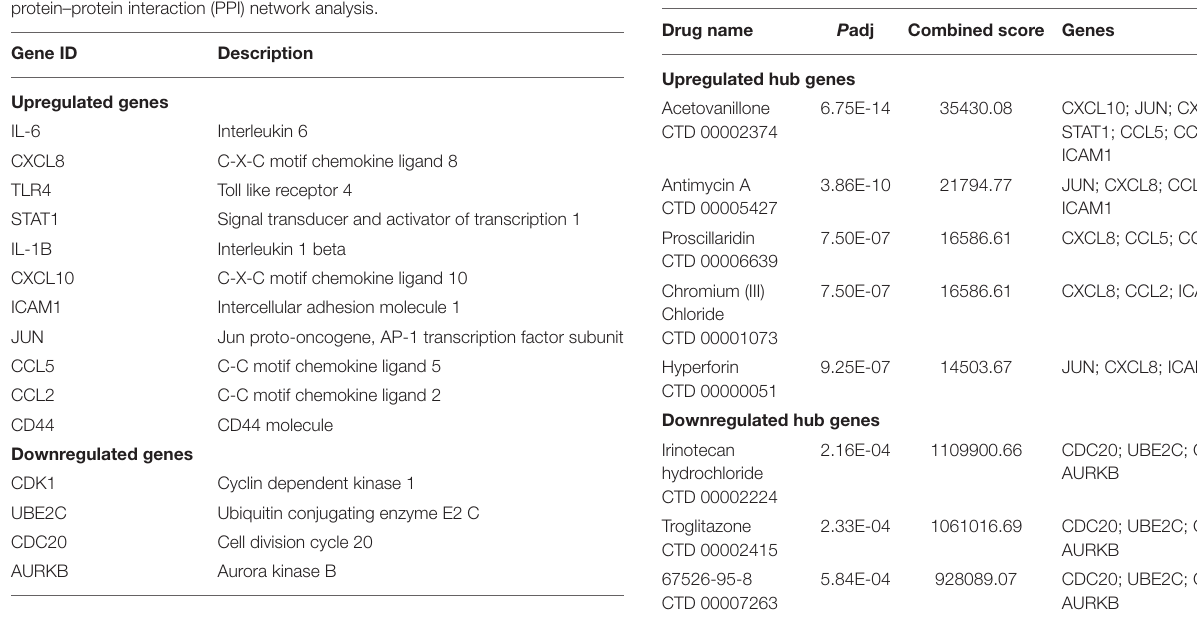
TABLE 5 | Drug candidates combined with hub